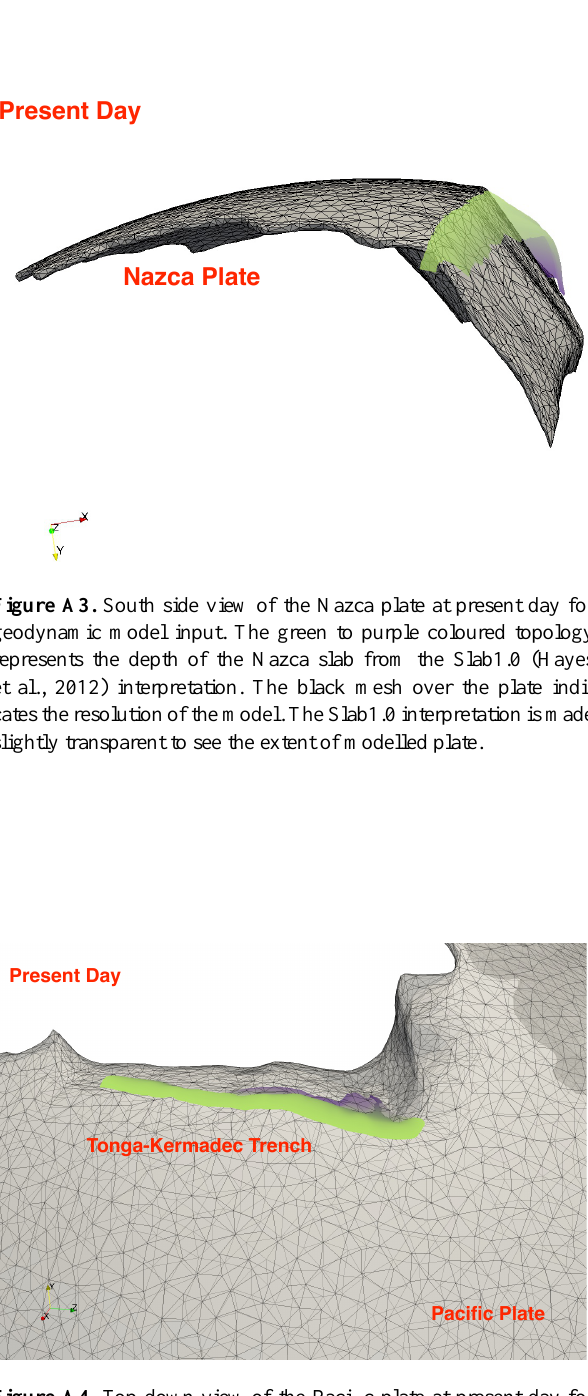
Figure A4. Top-down view of the Pacific plate at present day for geodynamic model input, localised over the Tonga-Kermadec sub- duction zone. The green to purple coloured topology represents the depth of the Kermadec slab from the Slab1.0 (Hayes et al., 2012) interpretation. The black mesh over the plate indicates the resolu- tion of the model. The modelled plate is made slightly transparent to see the extent of the Slab1.0